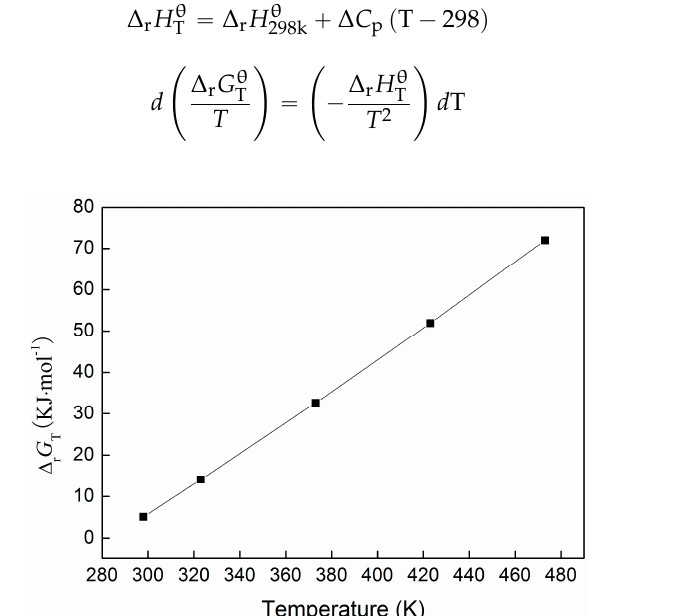
Figure 8. Dependence of temperature on the Gibbs energy of DEC synthesis from ethanol, CO 2 and PO.